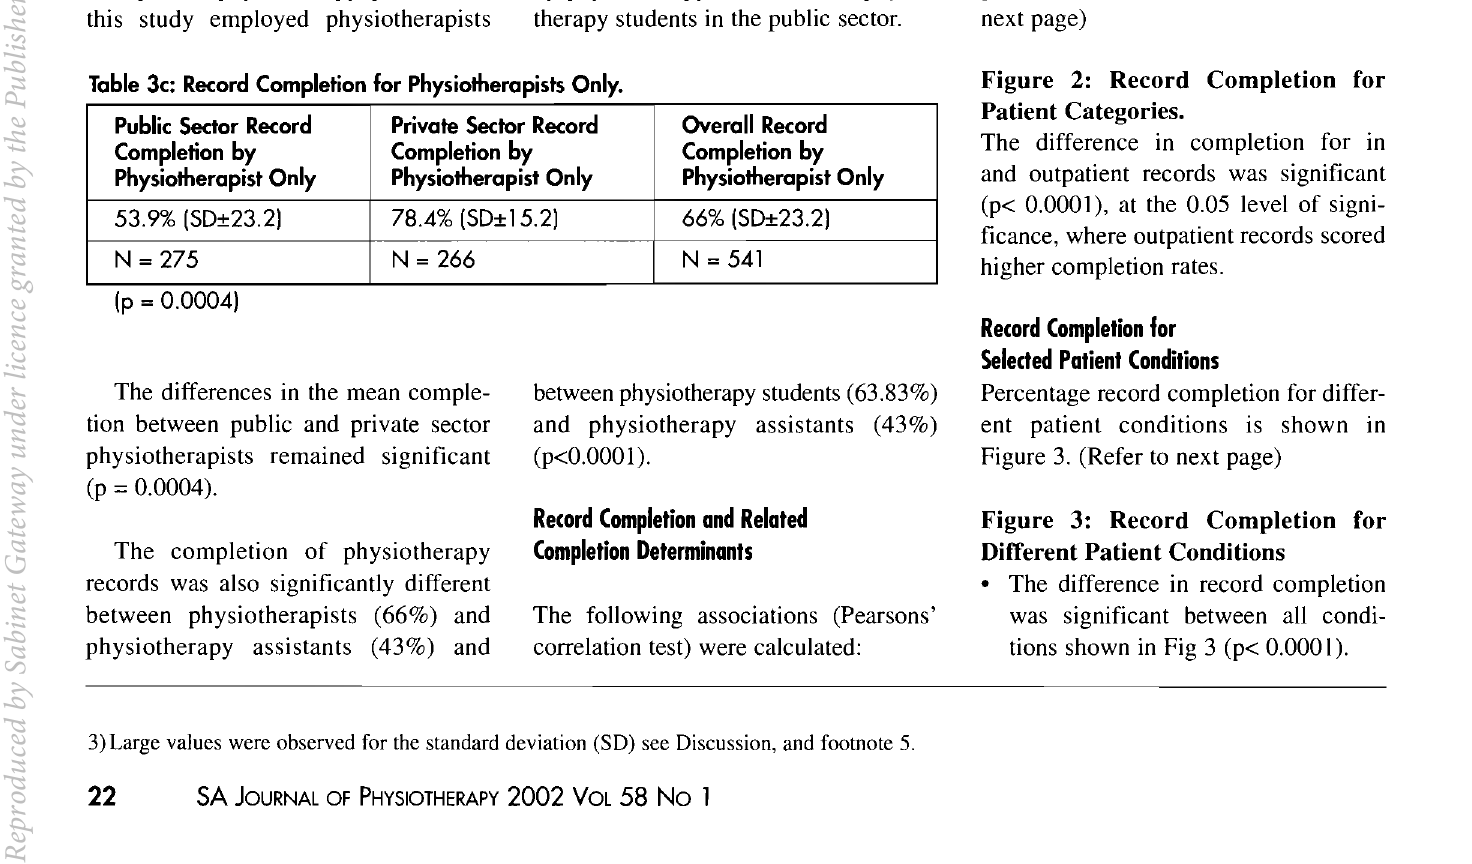
Figure 2: Record Completion for